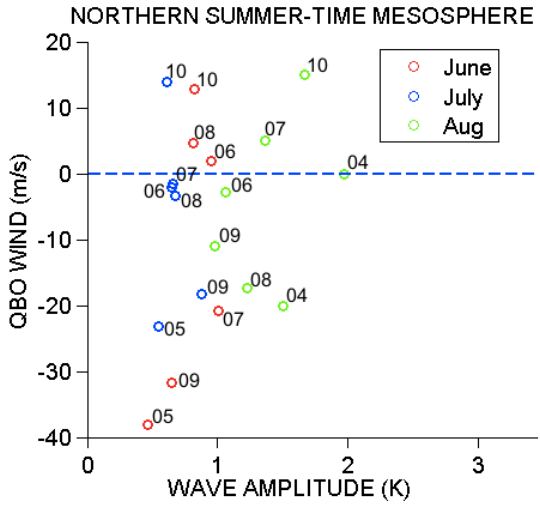
Fig. 11. Mean summer-time temperature amplitudes of the 16-day wave in the MLT at heights from ∼ 80–96km and latitudes of 50– 75 ◦ S as a function of QBO zonal winds at 10hPa.